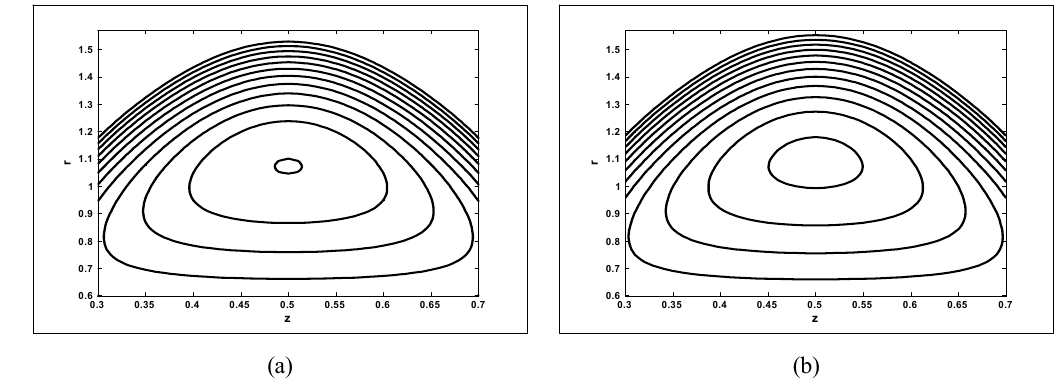
= M = M and ( b ) .6.0 The other = ,45.0 = Q 1 = = r when μ . r 1